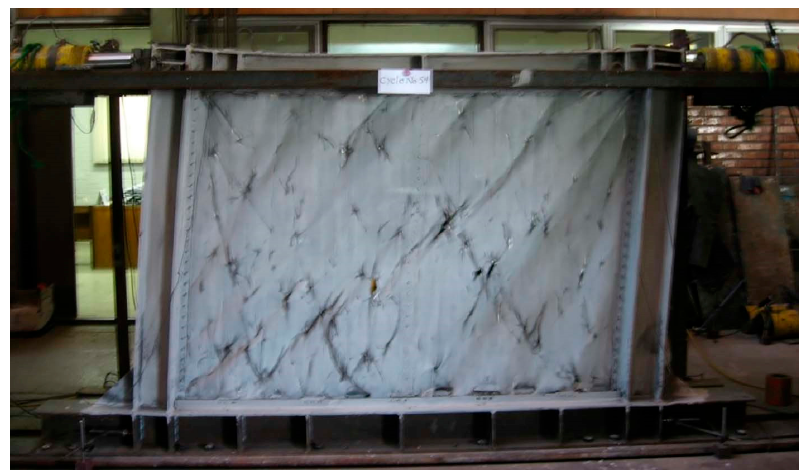
Figure 12. Specimen tested by Eamami et al. at the end of loading. Adapted from ref. [9].